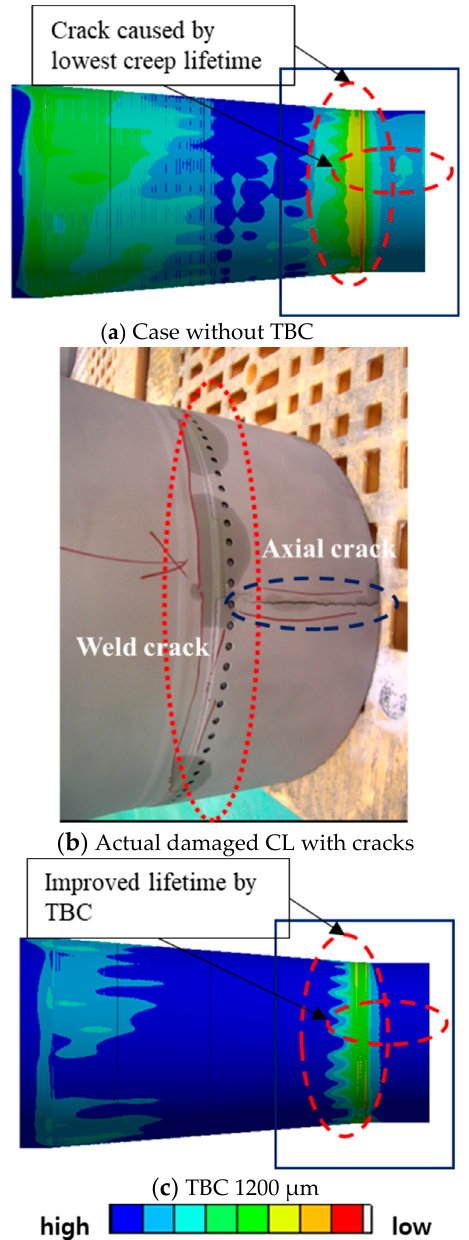
Figure 21. Comparison of cracks induced by thermal stress of the actual damaged CL and prevention by TBC thickness.